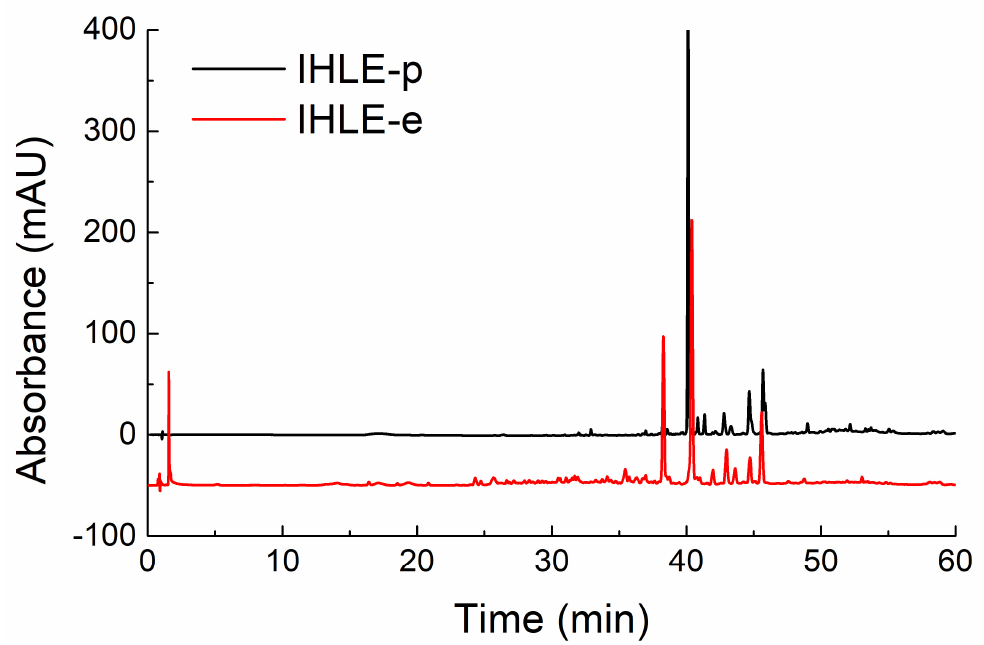
Figure 2. The chromatograms of IHLE-p and IHLE-e in HPLC analysis.